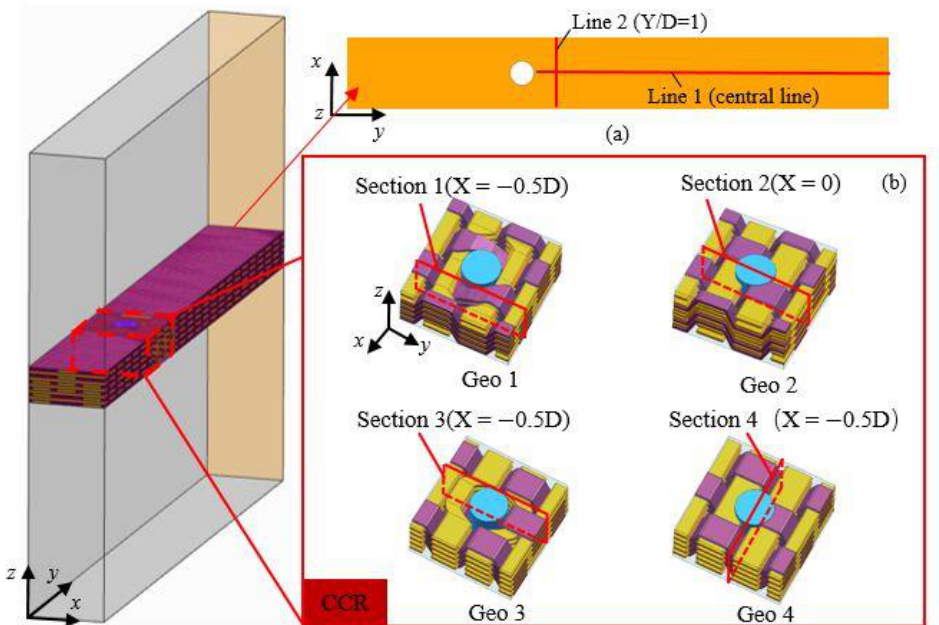
Figure 7. Diagram of the locations of characteristic sections and feature lines: ( a ) Schematic diagram of the line location; ( b ) Schematic diagram of the section location